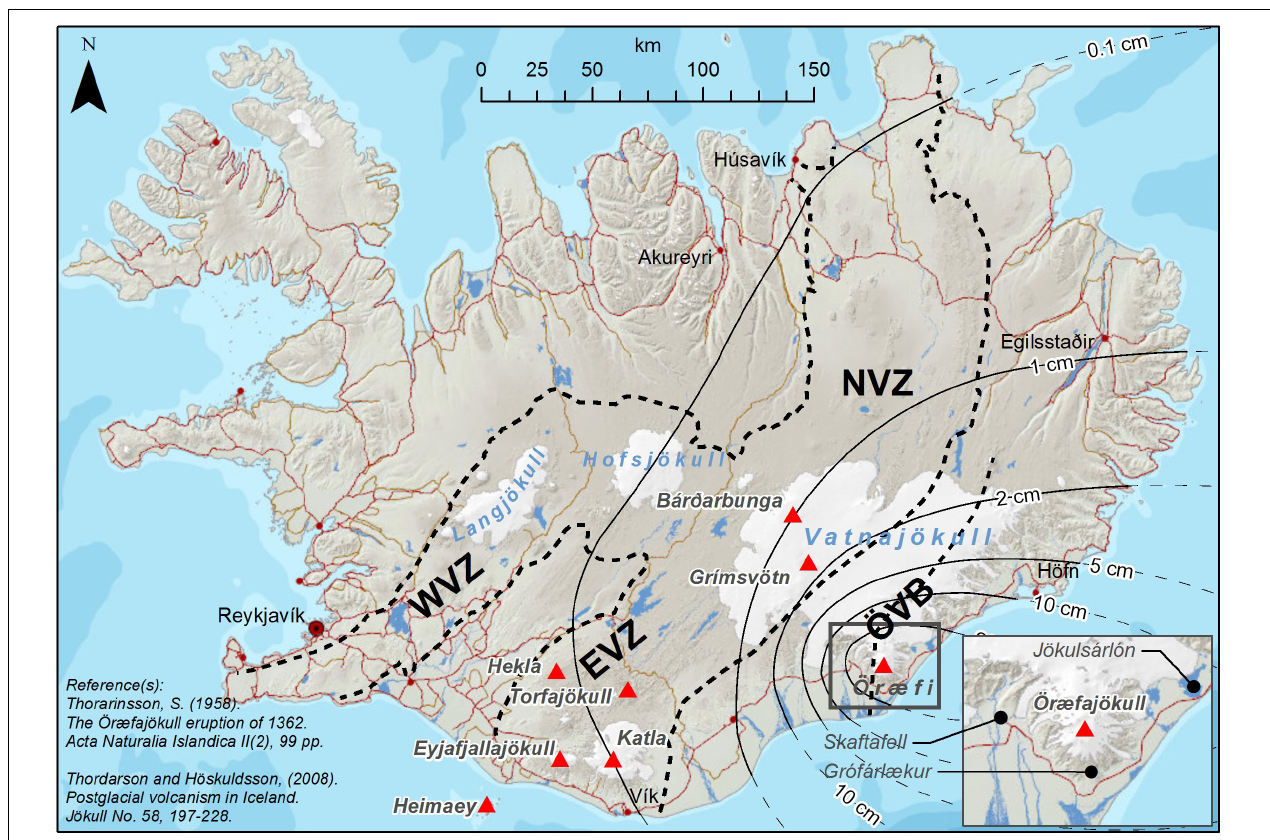
FIGURE 1 | Map showing the locations of Öraefajökull volcano and the main sites mentioned in the text. On top of it the reconstructed deposit for the 1362 AD eruption is